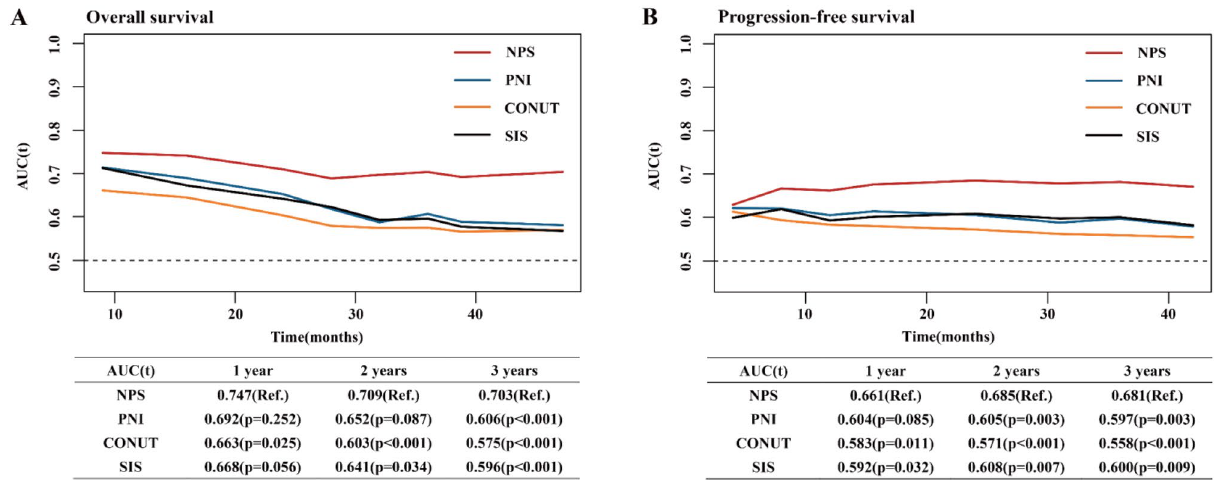
Figure 2. Time-dependent receiver operating characteristic curves of NPS, PNI, CONUT and SIS for prediction of survival. The time dependence of each area under the curve (AUC) for survival is shown at 1, 2 and 3 years. ( A ) Overall survival. ( B ) Progression-free survival. CONUT controlling nutritional status, NPS Naples prognostic score, PNI prognostic nutritional index, Ref. reference, SIS system inflammation